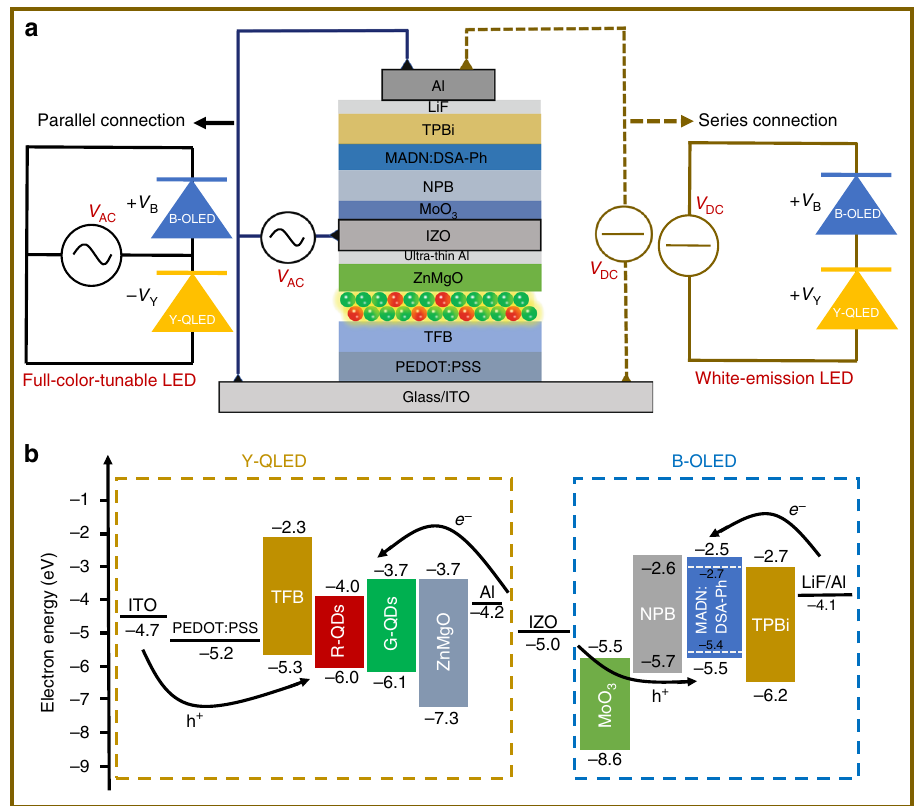
Fig. 1 Device structure and driving methods of the multifunctional LED. a Schematic device structure of the multifunctional tandem LED with an extractable IZO intermediate electrode. The Y-QLED and B-OLED can be connected either in parallel or in series. Under parallel connection and AC driving, a color-tunable device is achieved. Under series connection and DC driving, a white-emitting device is obtained. b Energy level alignment of the multifunctional tandem